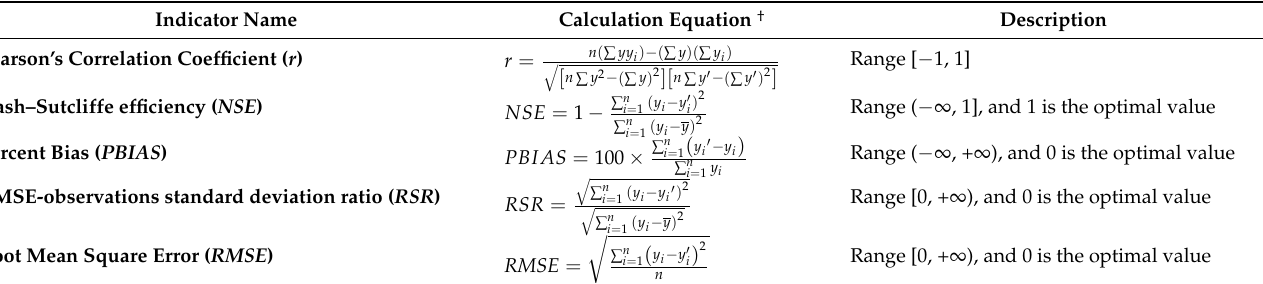
Table 3. Evaluation indicators of the model performance and their mathematic